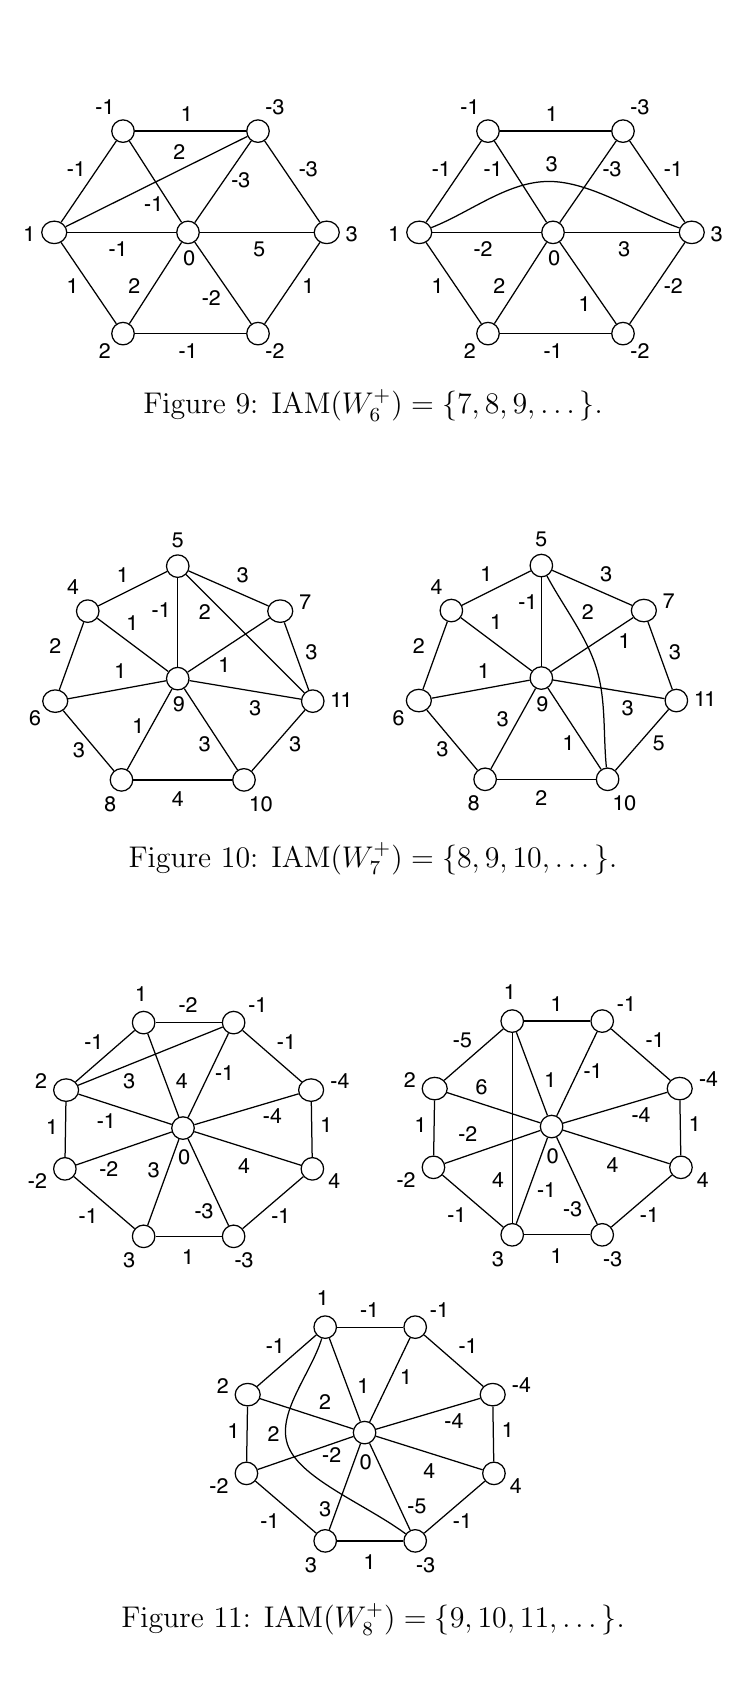
Figure 11: IAM( W +